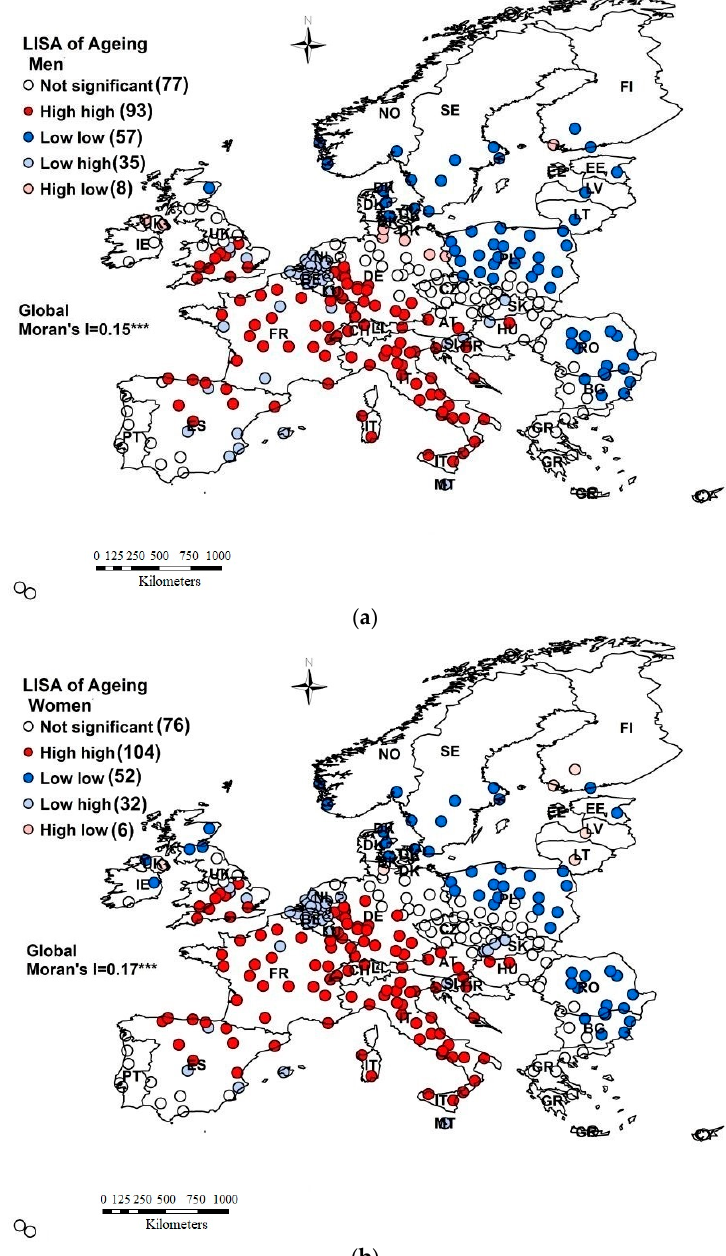
Figure 3. The spatial autocorrelation of the proportion of older men (a) and women (b) aged 65 or above measured by Moran's I statistic (averaged over the years 1990–2018). Source: Own elaboration in GeoDa and ArcGIS (ArcMap 10.5). Note: significance level: α = 0.01***; we used the threshold distance of 962 km and row standardized spatial matrix [55]. A comprehensive spatial weighting scheme for LISA (local indicators of spatial association) is available by email. In brackets we indicted the number of cities characterized by the LISA indices. Irrespective of the gender of the elderly person, the highest spatial concentration of urban units (high-high clusters) with the greatest share of seniors (from 11% to 24%) occurred in Italy, France,